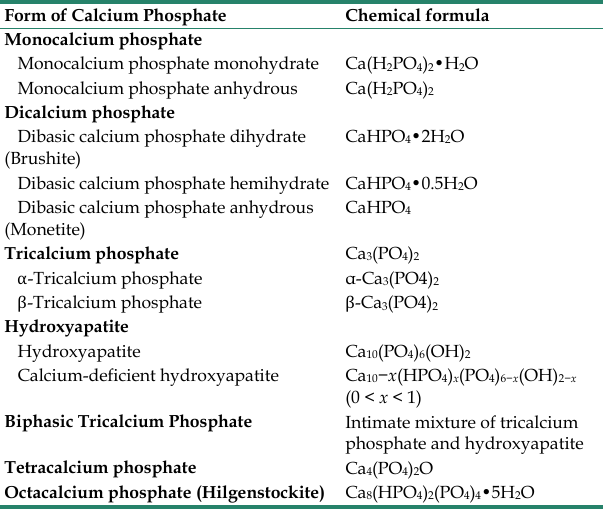
Table 1. Different forms of calcium phosphate.